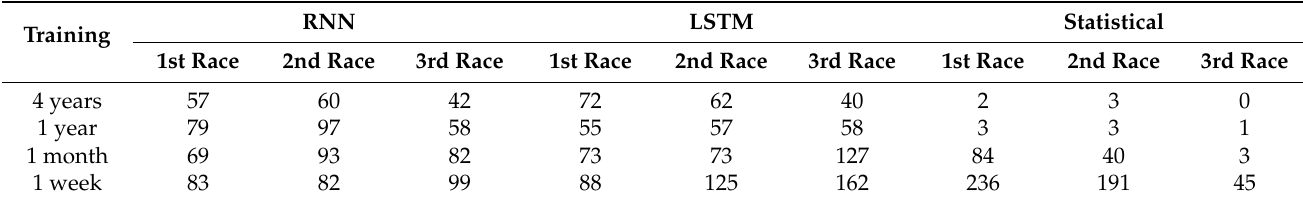
Table 2. Experimental comparison between RNN, LSTM, and